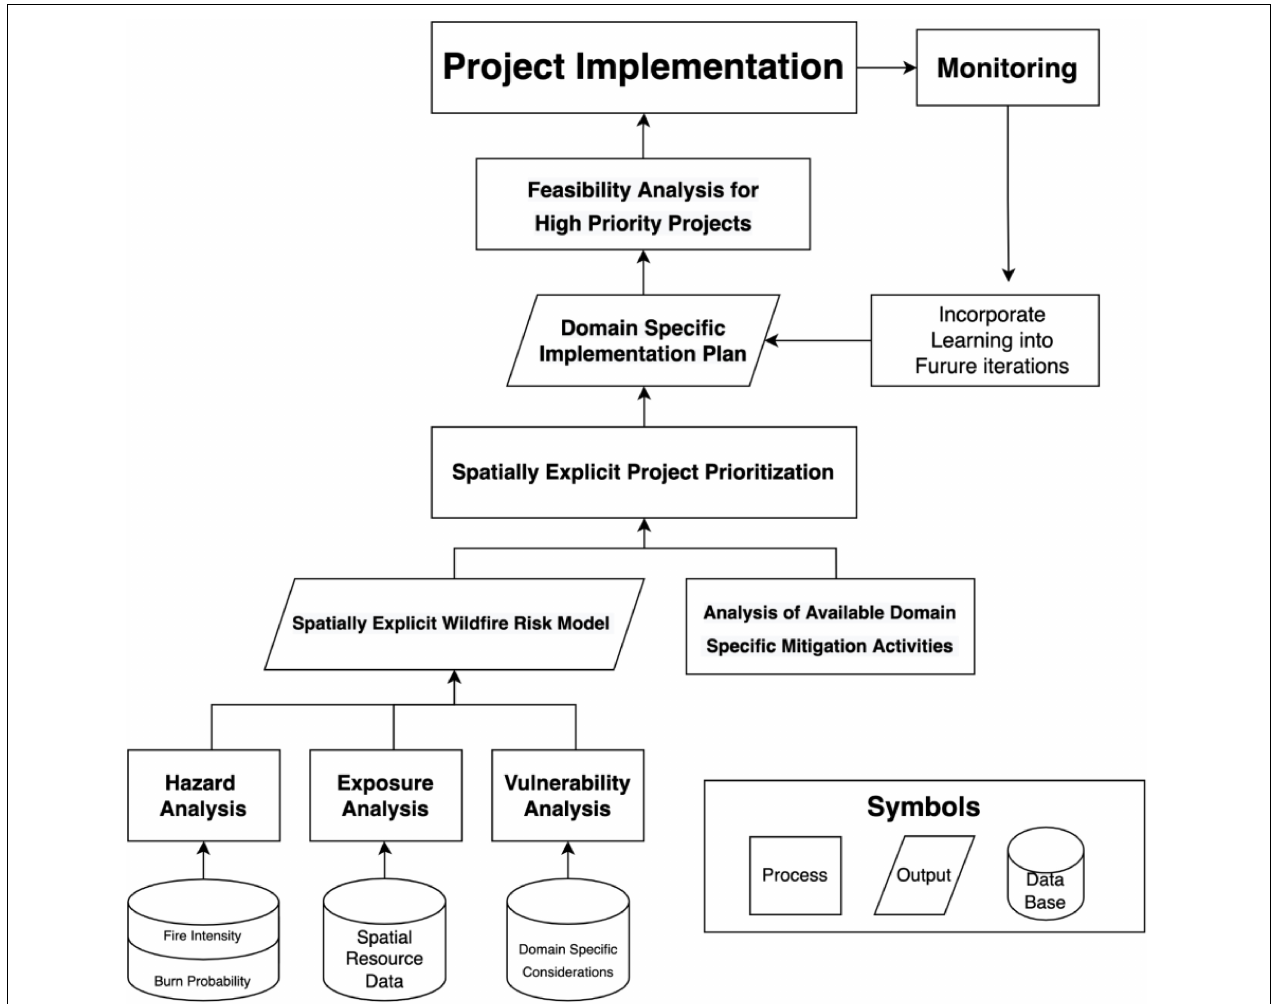
FIGURE 8 | Regional Wildfire Mitigation Program analytical flow, ultimately creating a prioritized implementation plan for each